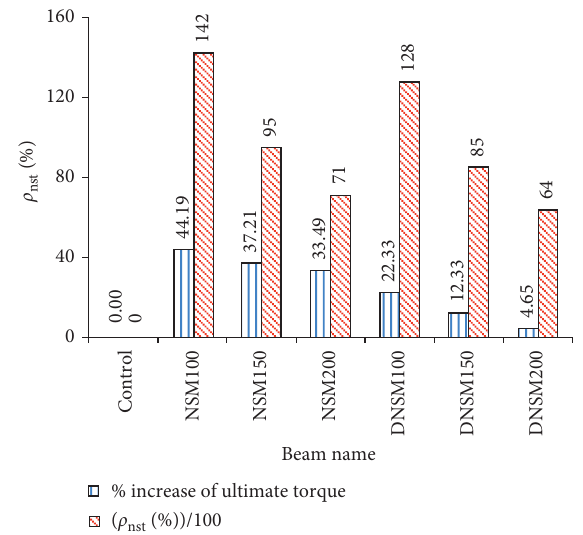
Figure 11: NSM steel ratios and percentage improvements in the ultimate torque of the beam specimens.